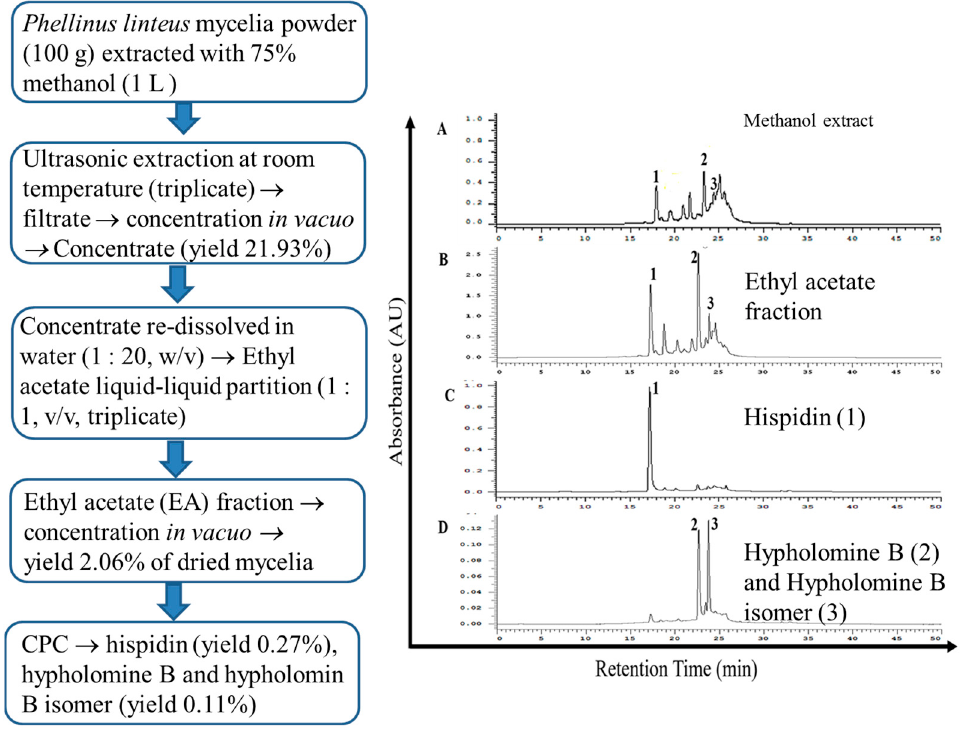
Figure 1. Experimental procedures of solvent extraction, partition and purification of extract prepared using the Phelinus linteus mycelia extract and HPLC analysis of extracts obtained in each procedure. ( A ) 75% methanol. ( B ) ethyl acetate. ( C ) hispidin. ( D ) hypholomine B and hypholomine B isomer. Peaks 1: hispidin; 2: hypholomine B, and 3: hypholomine B isomer.